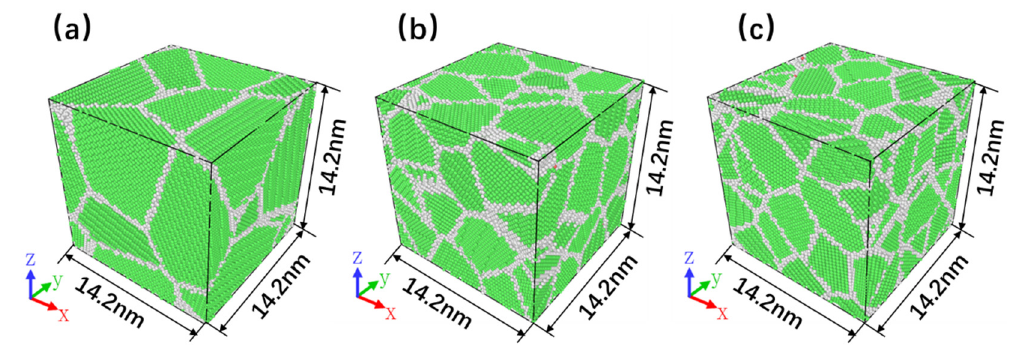
ff erent grain sizes of ( a ) 6.6, ( b ) 4.6, and ( c ) 3.8 Figure 1. Nanocrystalline TiAl models with different grain sizes of ( a ) 6.6, ( b ) 4.6, and ( c ) 3.8 nm. Figure 1. Nanocrystalline TiAl models with di